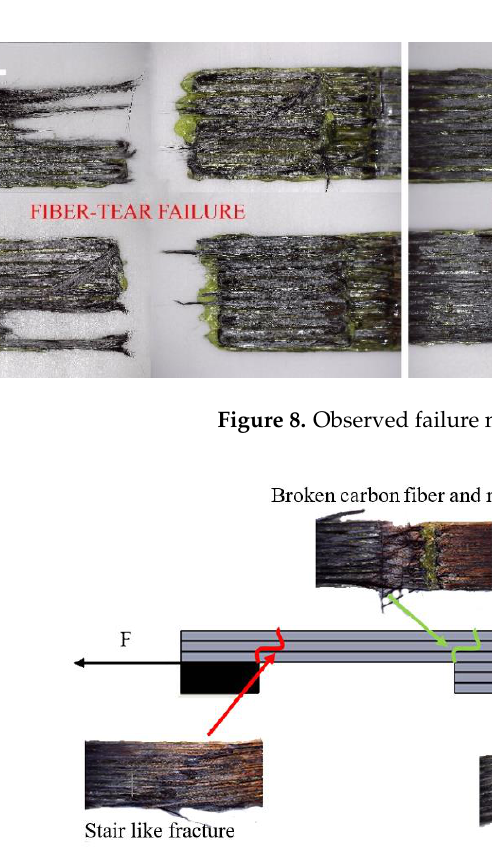
Figure 9. Schematic diagram of specimen fracture patterns.